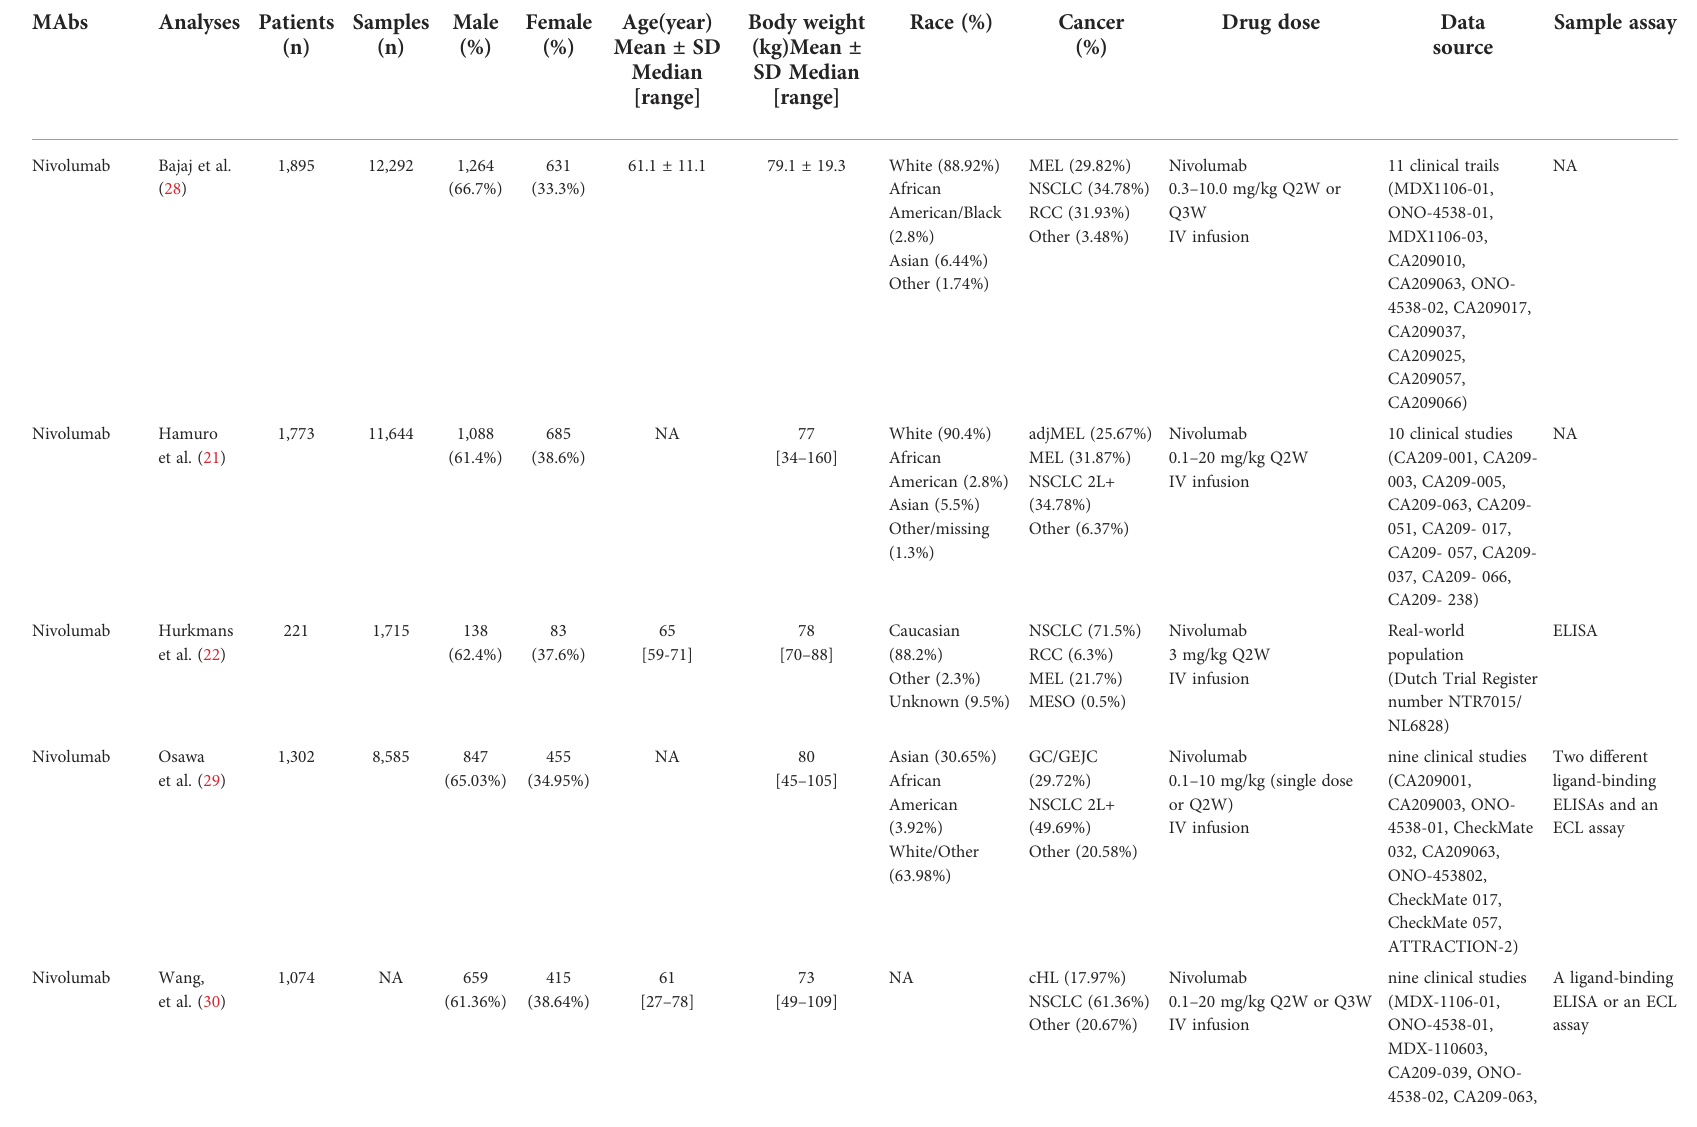
TABLE 2 Studies design and characteristics of the